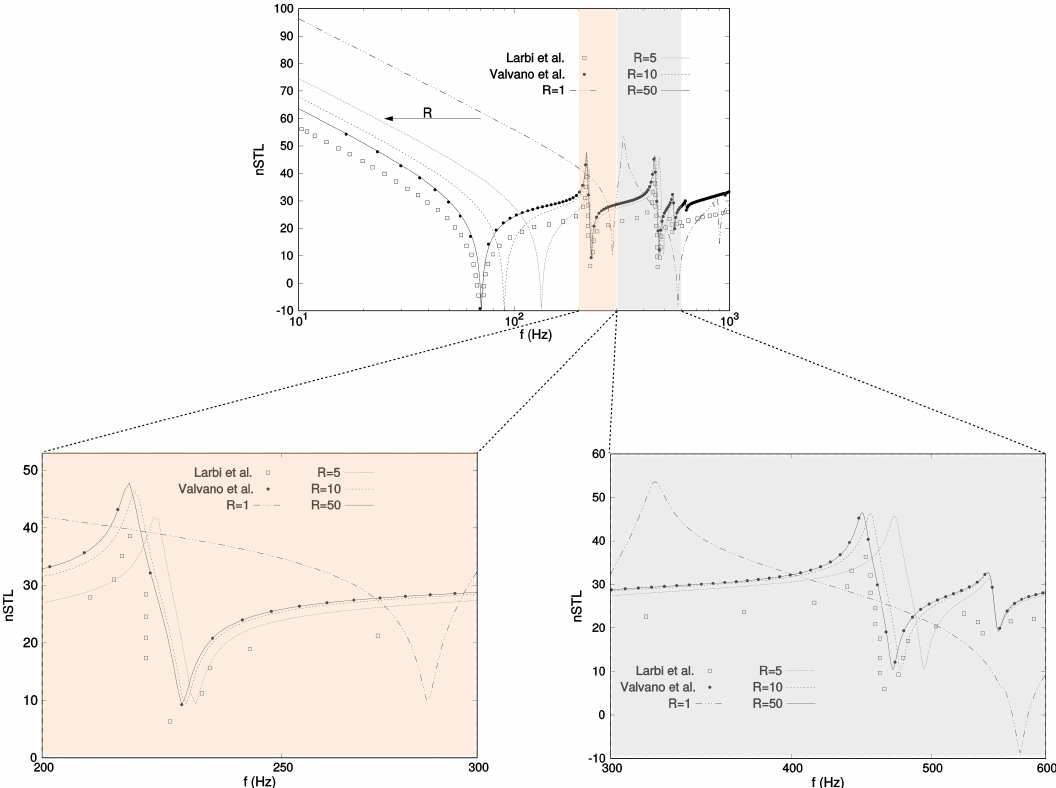
Figure 5. Simply-supported rectangular cylindrical shell. Normal incidence sound transmission levels ( nSTL ) . Study of the radius convergence with respect to the flat plate reference solution.